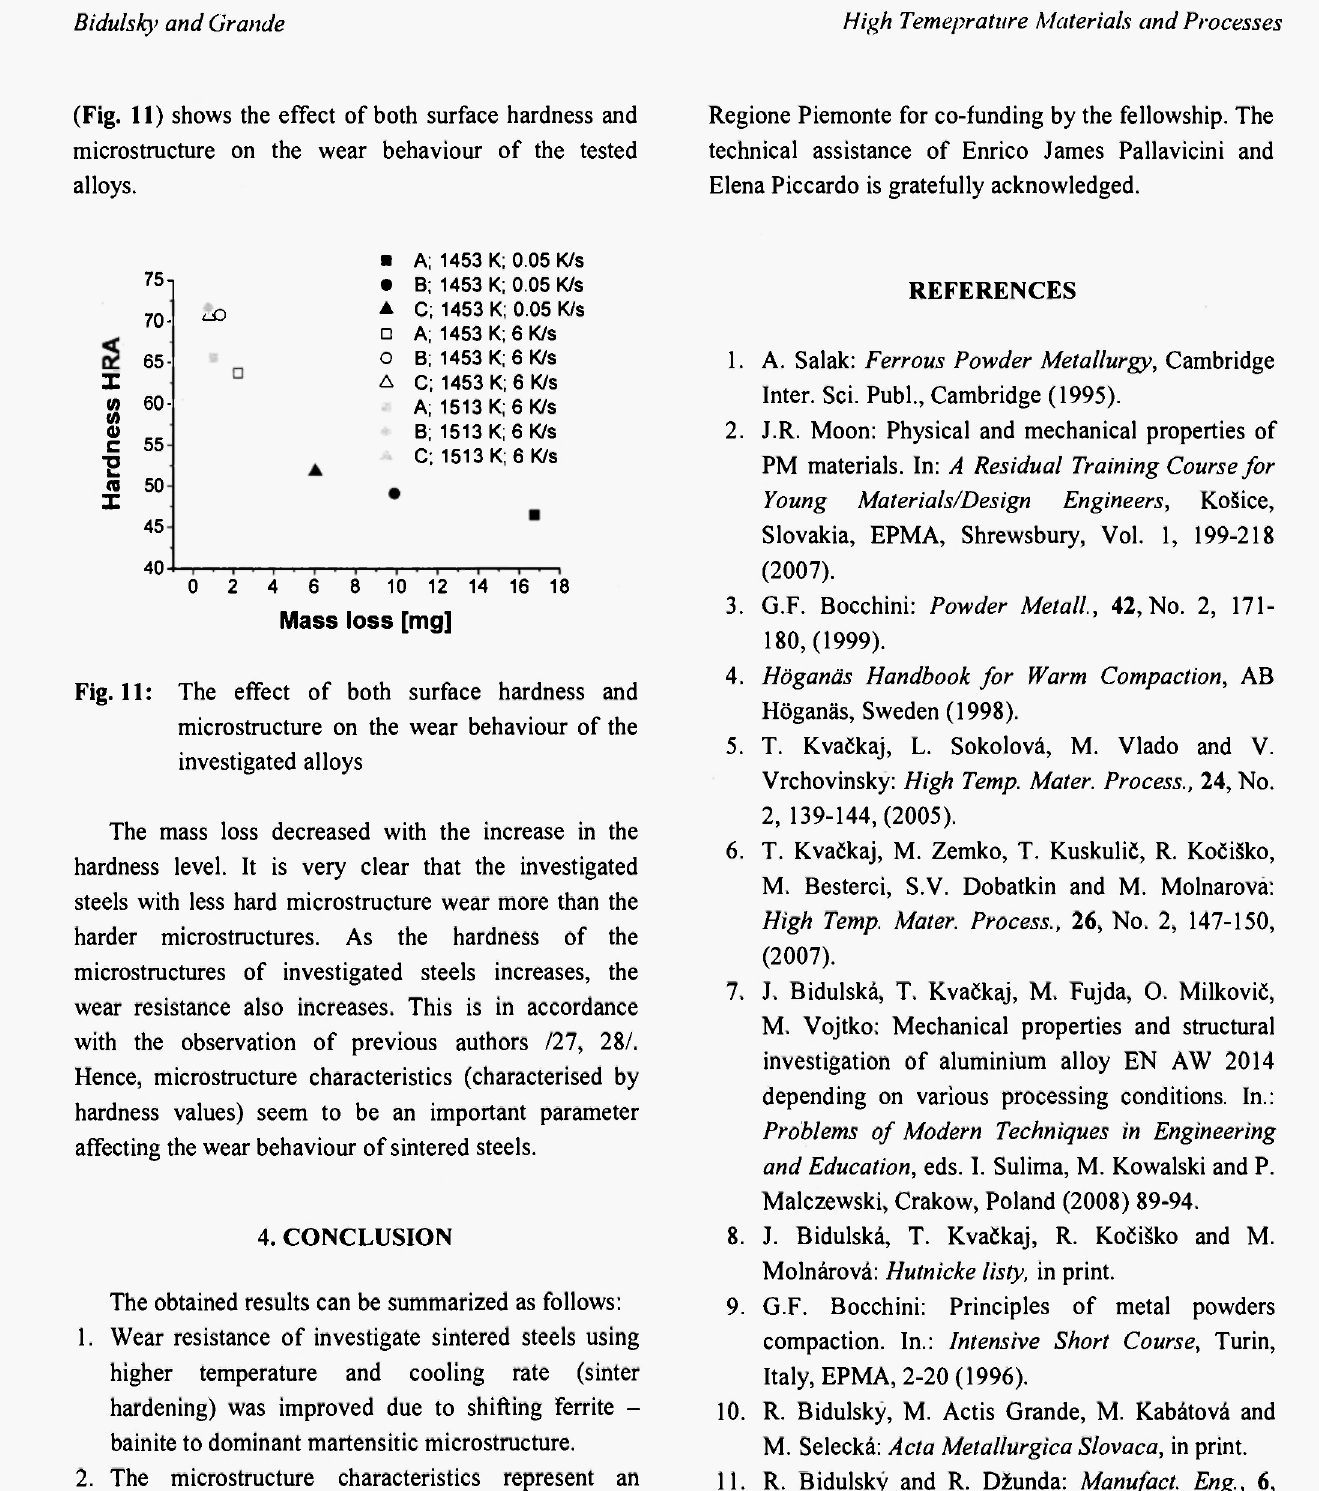
The effect of both surface hardness and microstructure on the wear behaviour of the investigated alloys The mass loss decreased with the increase in the hardness level. It is very clear that the investigated steels with less hard microstructure wear more than the harder microstructures. As the hardness of the microstructures of investigated steels increases, the wear resistance also increases. This is in accordance with the observation of previous authors /27,